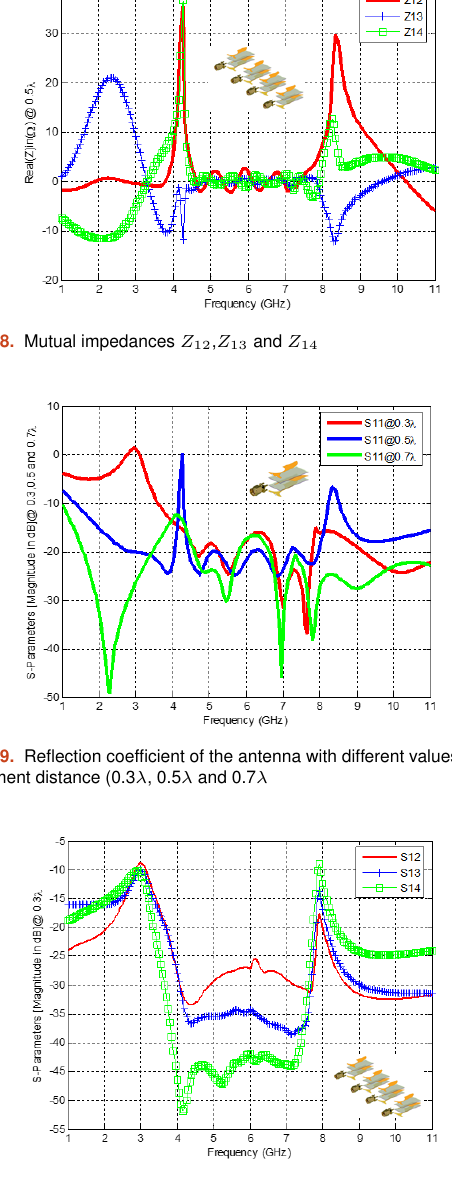
FIGURE 10. Parametric study of the broadband mutual coupling for different values of inter-element distance (0.3 λ ) (4 antennas